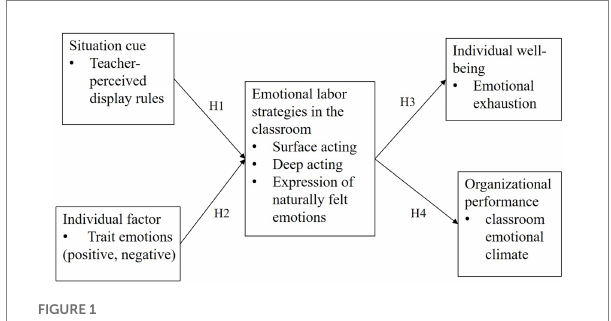
FIGURE 1 Hypothesis model of this